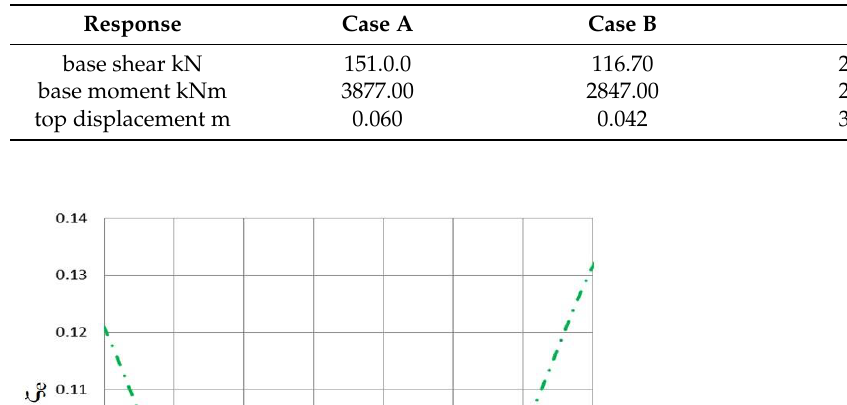
Table 4. Comparison of the results obtained from the first linear elastic finite element model (FEM_1)— CASE A and from the FEM_1—CASE B.